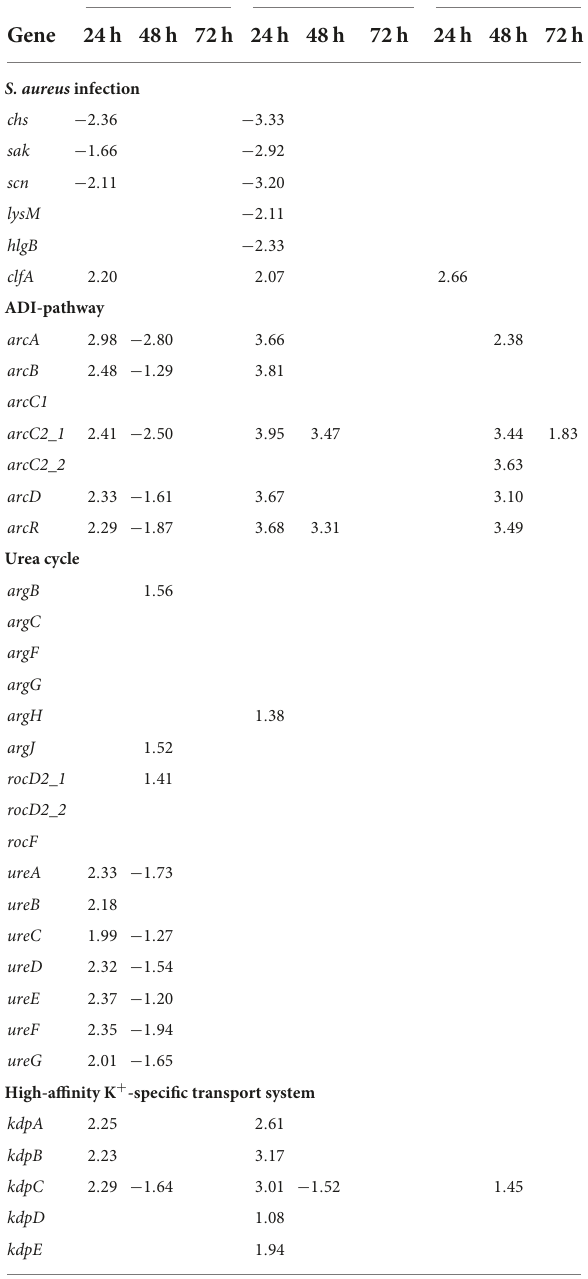
TABLE 2 Differentially expressed genes [log 2 (fold change)] in S. aureus infection-related pathways, ADI pathway, urea cycle, and high-affinity K + -specific transport system during biofilm growth compared to the planktonic phenotype of UAS391, HEMRSA-15, and ST239-16